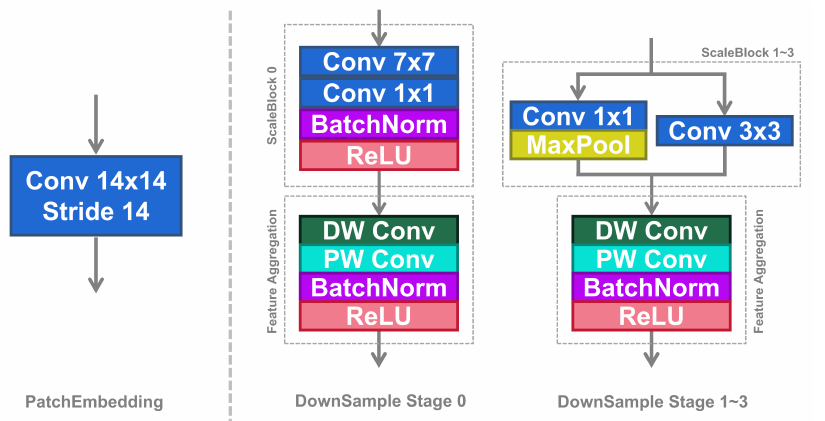
Figure 2. The details of the GradualEmbedding module.